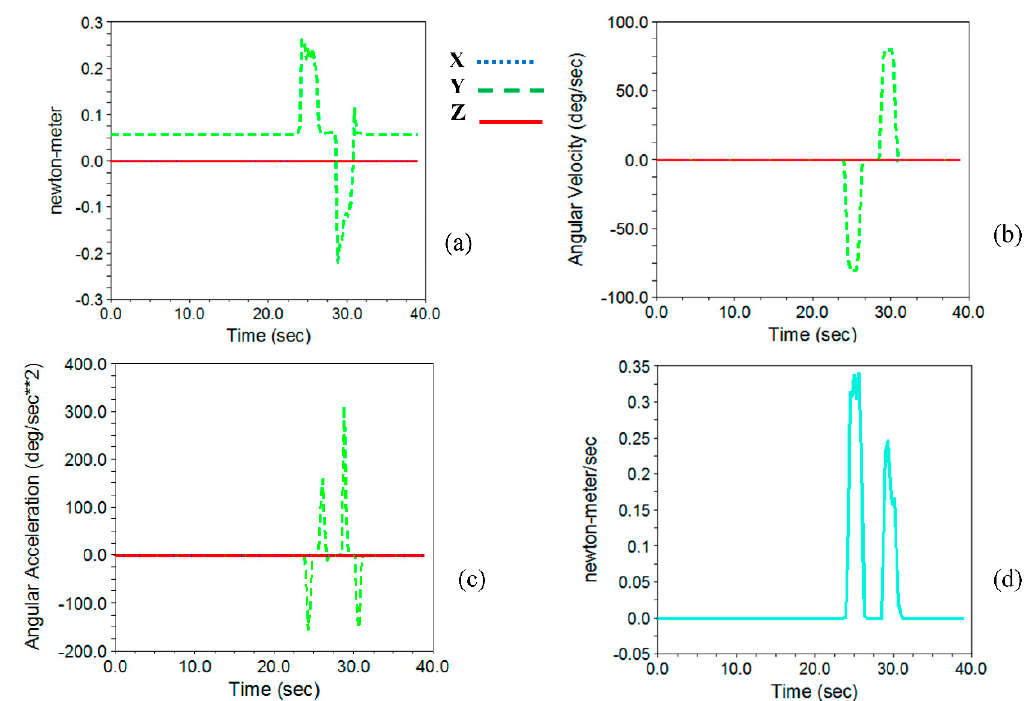
Figure 23. Results of ADAMS software simulation to determine the motor characteristics of the gutting subset (four fish per minute). In this figure, ( a – d ) are torque, angular velocity, angular acceleration, and required power respectively.